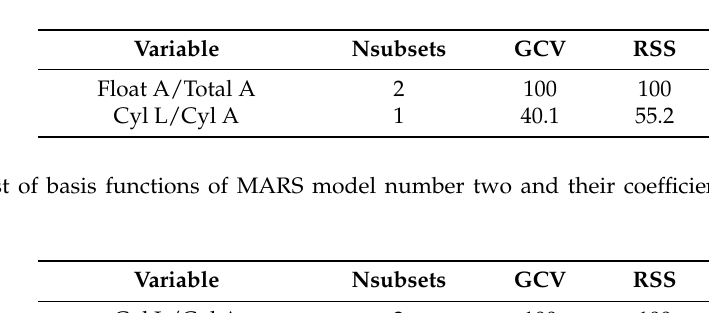
Table 7. List of basis functions of MARS model number two and their coefficients for feed with media.